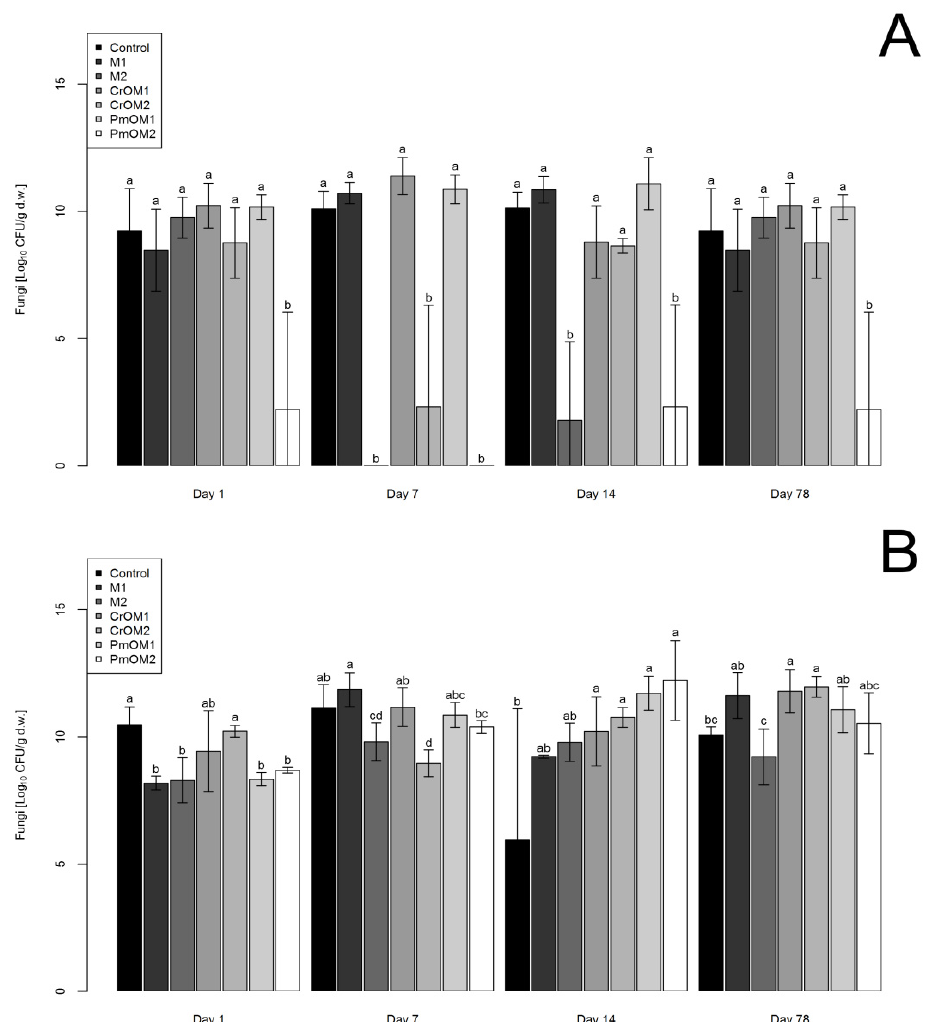
Figure 2. The abundance of fungi in sandy ( A ) and loamy ( B ) soils depending on different treatments with maltodextrin (M1 and M2) and encapsulated essential oils of caraway (CrOM1 and CrOM2) and peppermint (PmOM1 and PmOM2). 1 and 2 refer to doses of microcapsules, 50 and 200 g per 1 kg of soil, respectively. Letters on error bars denote statistical significance among groups according to Duncan’s MLR post hoc test at level p < 0.05.